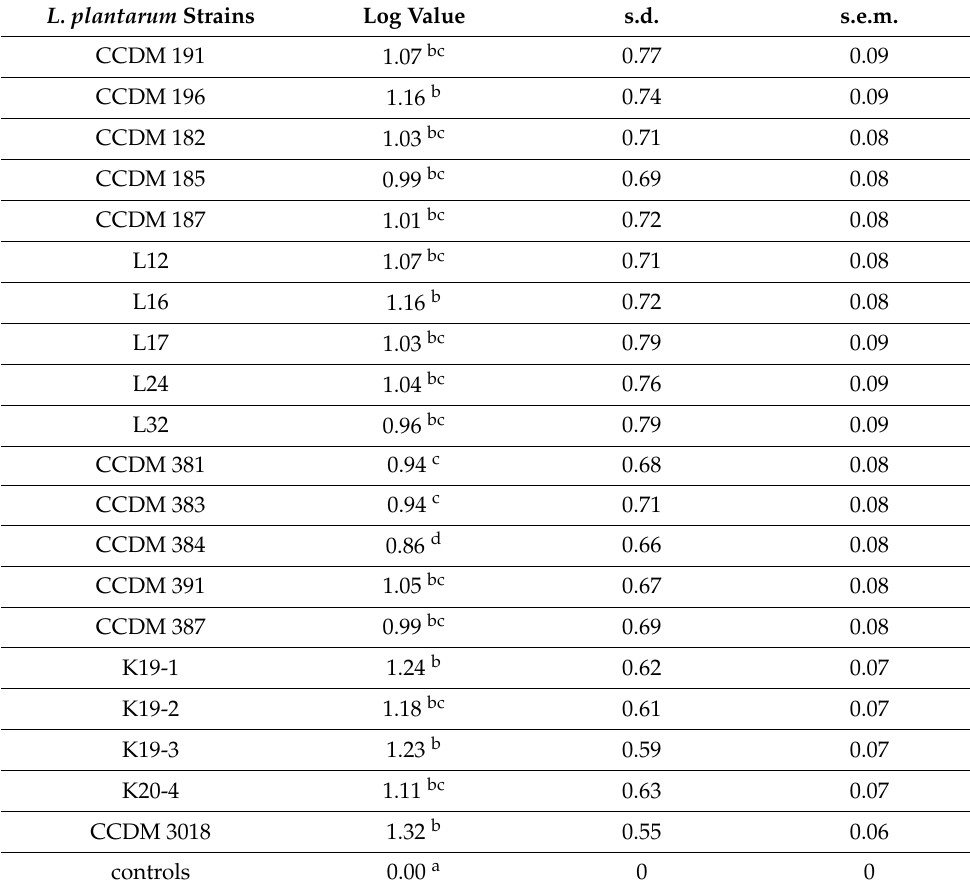
Table A2. The variability in antifungal effect of 20 strains of L. plantarum in in vitro tests on artificial media against 25 yeast strains. The data represent logarithmically transformed index scale values, standard deviation (s.d.) and standard error of means (s.e.m.). F (24,1050) = 96.87; p ≤ 0.00 E ≤ 0.05. (Factorial ANOVA, Statistica v. 12. Post Hoc Tukey’s HSD Test). The index letter indicates significant differences. Significant at α ≤ 0.05.